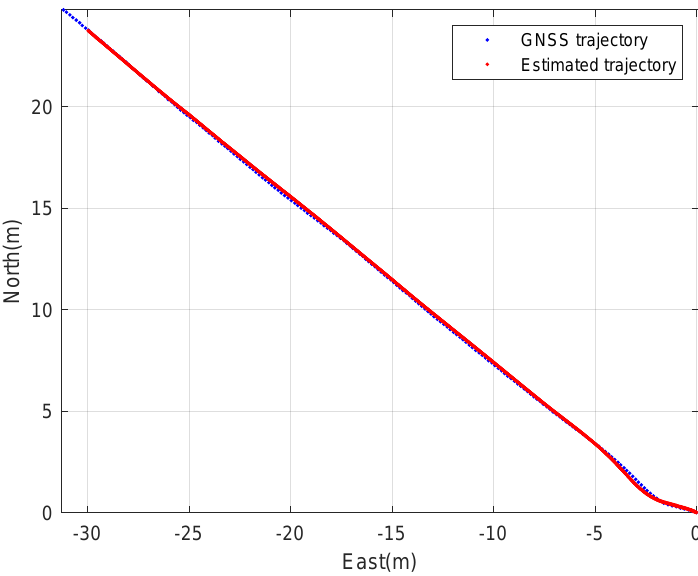
Figure 10. The 2D trajectory of the rover: a straight driving test.